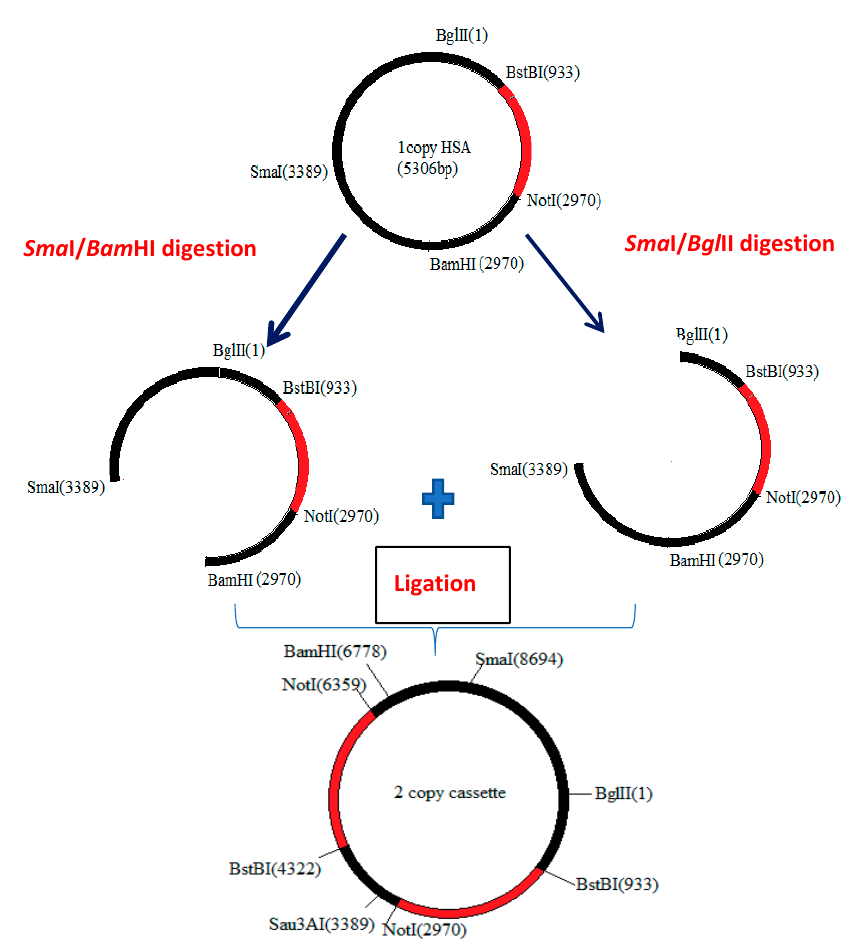
Figure 1. Scheme for construction of the two-copy human serum albumin (HSA) vector (the red region indicates HSA expression cassette). The sizes shown are not to actual scale.